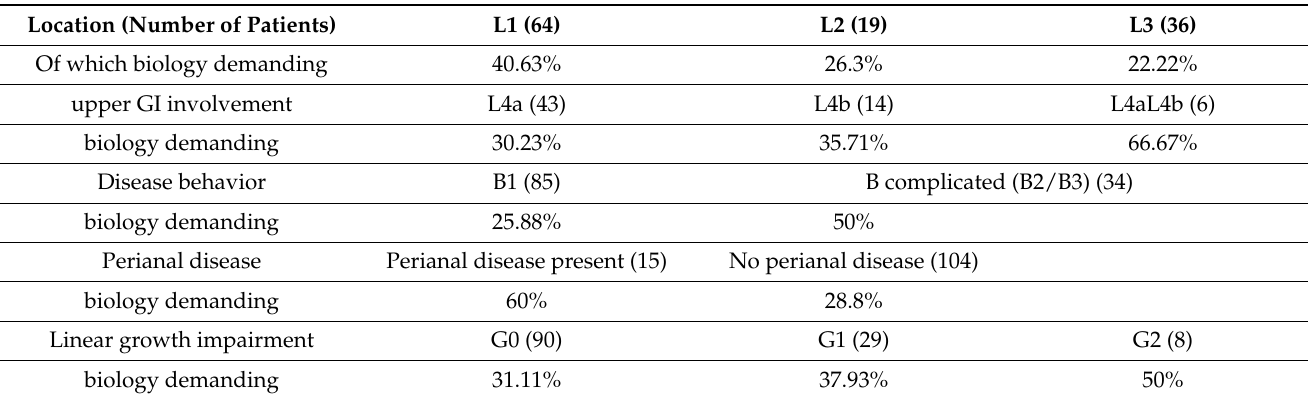
Table 1. Paris classification. In brackets number of patients in each subgroup (presenting with each disease location/behavior) is